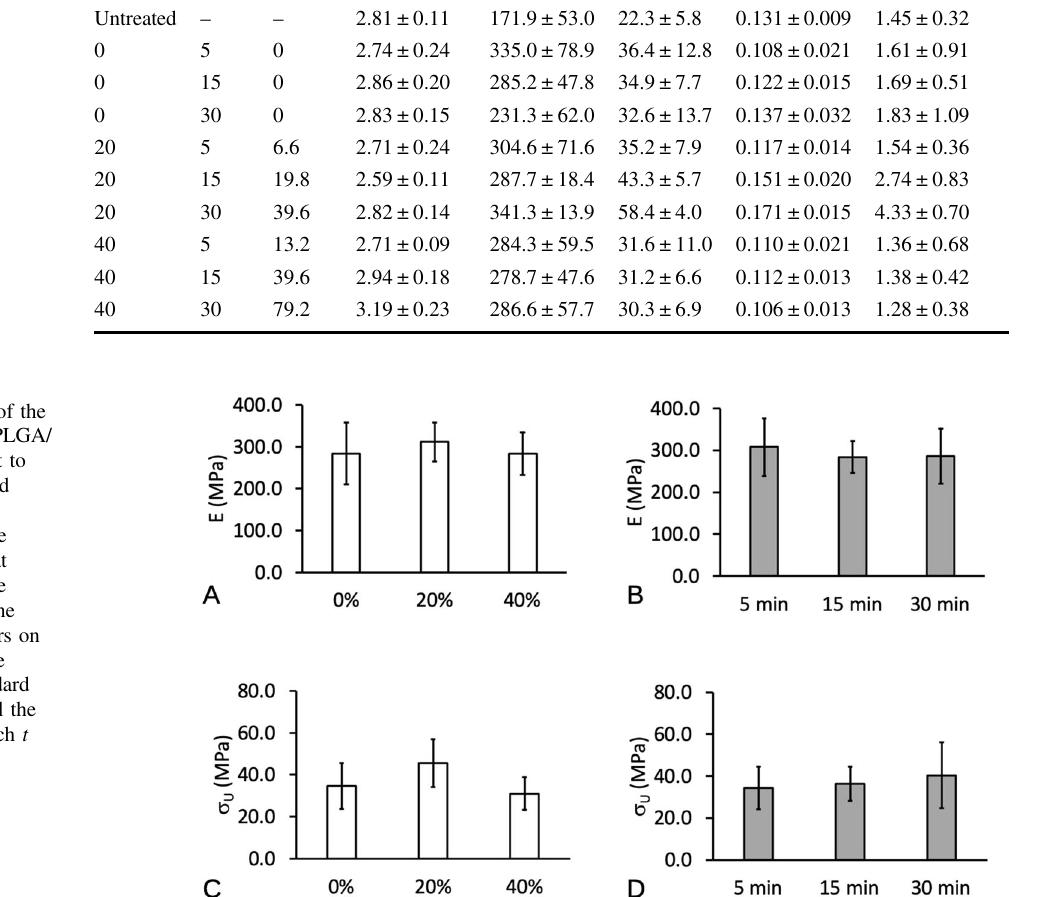
Table 2 Summary of results from compression testing of PLGA/PVA